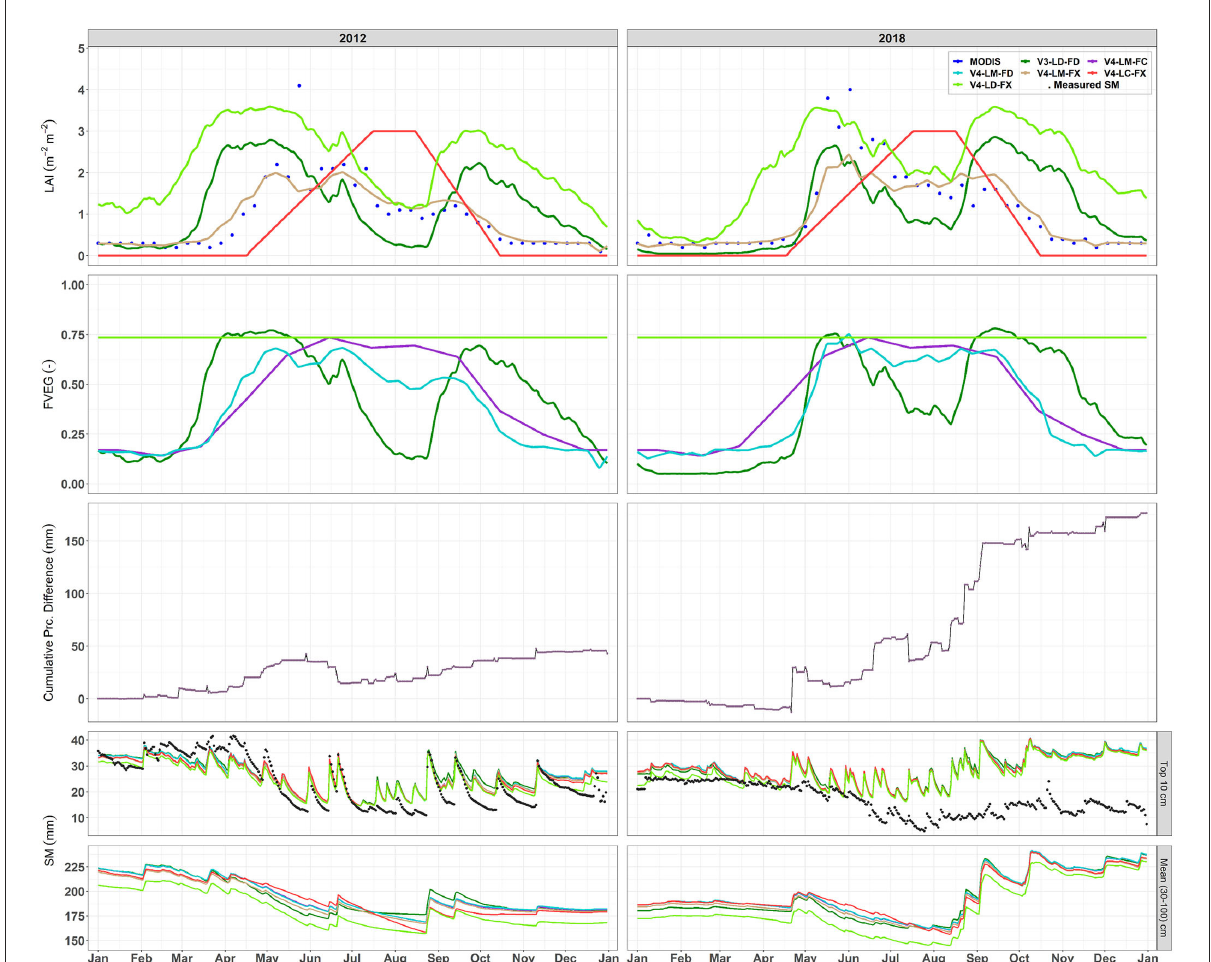
FIGURE6 Comparison of average daily simulated LAI from all different Noah-MP configurations vs. MODIS measurements (top panel), simulated FVEG (second panel), and simulated soil moisture for the top layer (10cm) compared to the field measurements (black dots) and average soil moisture for the three bottom soil depths (30, 60, and 100cm) (bottom panels) throughout the selected drought years (i.e., 2012 and 2018) at the KON